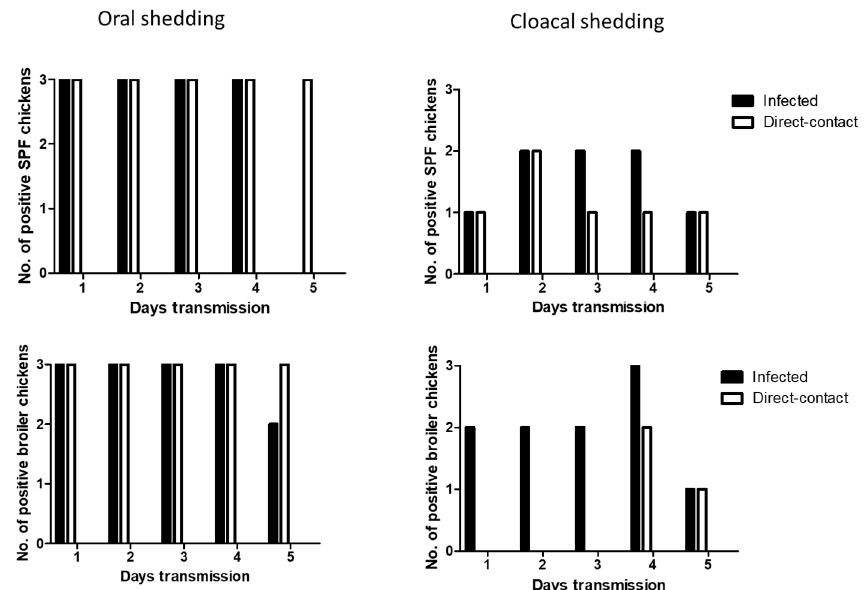
Figure 4. Transmission of H7N2 in SPF and broiler chickens. Three infected birds with each virus (10 7 pfu/mL) and three contact exposure birds (naïve birds) were placed in an isolator in one day apart. From following day, swab samples were collected daily up to 5 days for virus shedding.